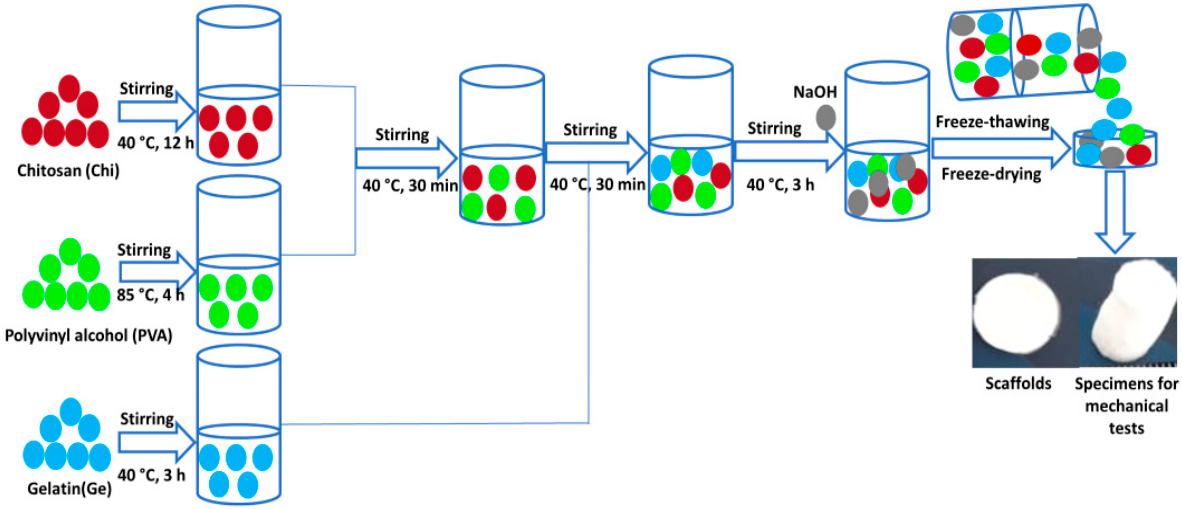
Figure 1. Schematic illustration of the preparation process of the sample’s scaffolds. Table 1. Compositions and ID of Chi/Ge/PVA ternary blend scaffold and controls. Scaffolds Blending Ratio